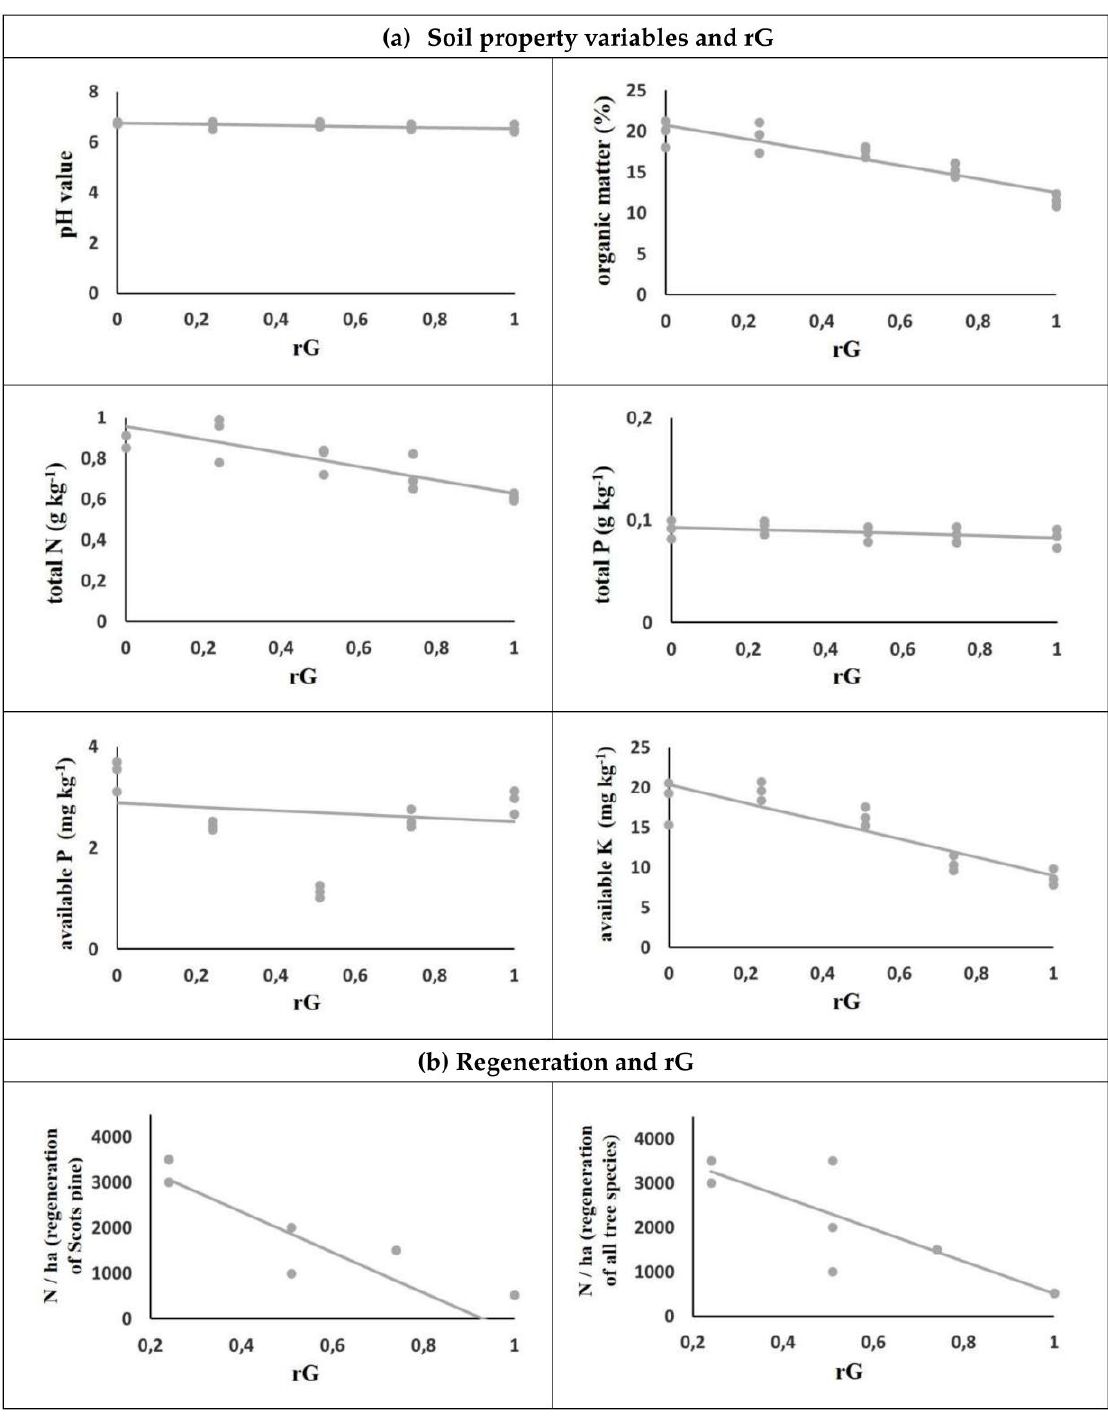
Figure 7. ( a ) Graphs of the relationships between soil property variables and selective logging intensity (rG; selective logging weight); ( b ) Graph of the relationship between regeneration (N/ha) and selective logging intensity (rG; selective logging